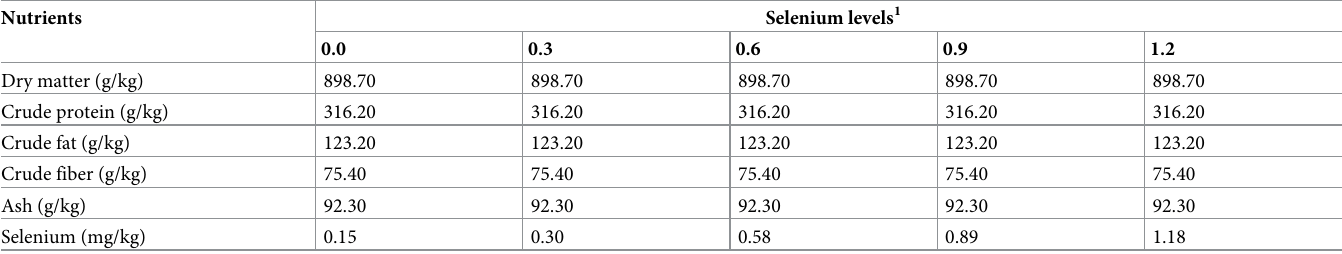
Table 2. Diets chemical composition on a dry